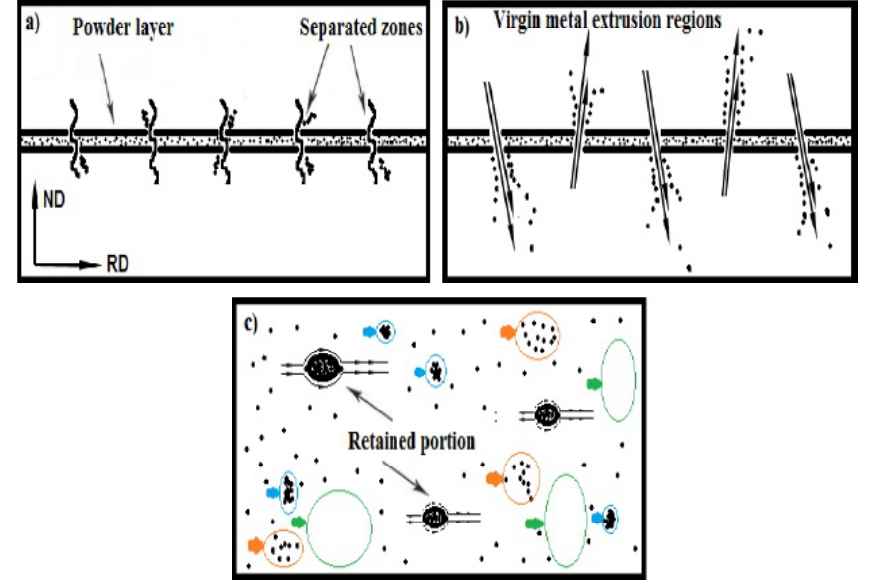
Fig. 7. The schematics of powder layer separation and dispersion of particles in (a) matrix (b) initial cycles and(c)final cycles of